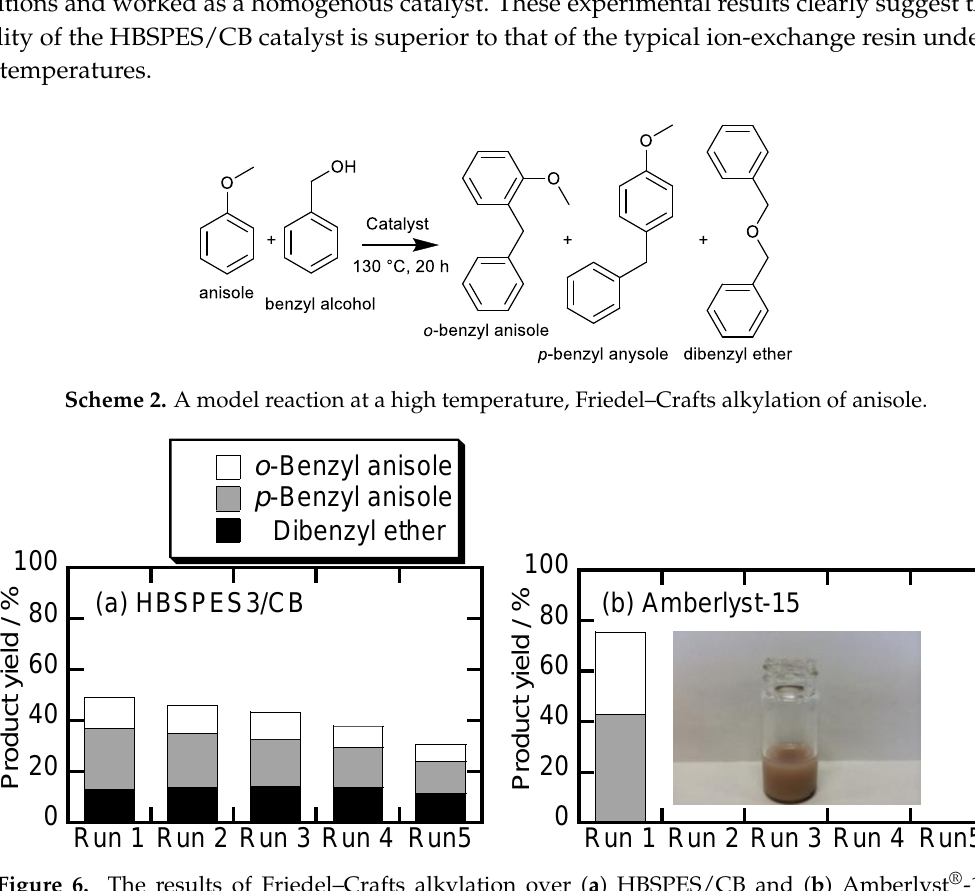
Figure 6. The results of Friedel–Crafts alkylation over ( a ) HBSPES/CB and ( b ) Amberlyst ® -15. Conditions: anisole 18.5 mmol, benzyl alcohol 1.25 mmol, catalyst 75 mg, 130 °C, 20 h. Inset: the reaction mixture after the first run with Amberlyst ® -15 [9].